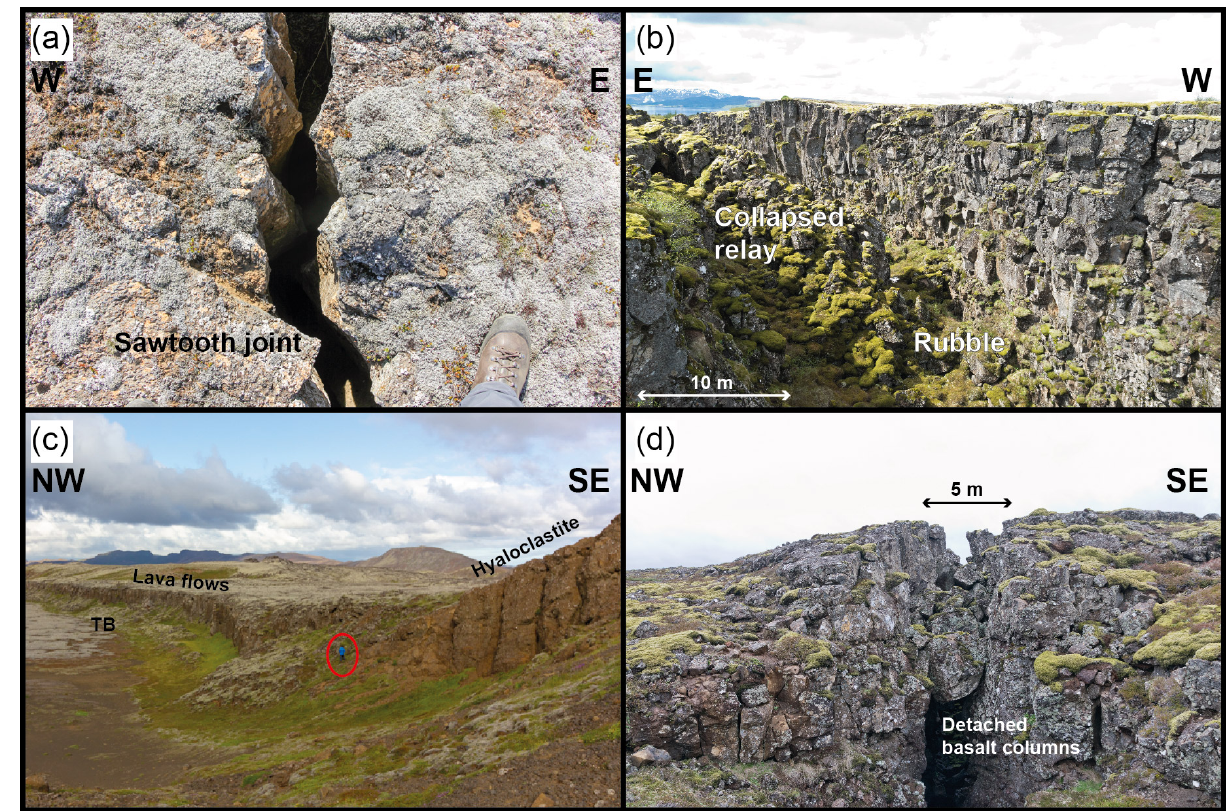
Figure 4. (a) Cooling joint with the typical sawtooth pattern; 66 ◦ 2 (cid:48) 55 (cid:48)(cid:48) N, 16 ◦ 37 (cid:48) 48 (cid:48)(cid:48) W. (b) MDF in Thingvellir. The relay has collapsed, filling the opening of the fault with rubble; 64 ◦ 14 (cid:48) 34 (cid:48)(cid:48) N, 21 ◦ 8 (cid:48) 38 (cid:48)(cid:48) W. (c) A fault that dissects different material developed tilted blocks: lava flows on the left and softer hyaloclastite on the right. Person for scale; 63 ◦ 51 (cid:48) 48 (cid:48)(cid:48) N, 22 ◦ 11 (cid:48) 41 (cid:48)(cid:48) W. (d) Side view inside a dilatant fault. Note the detached basalt columns that are stuck between the fracture walls, preventing the cavity beneath from being filled by further rubble from above; 63 ◦ 57 (cid:48) 58 (cid:48)(cid:48) N, 22 ◦ 20 (cid:48) 13 (cid:48)(cid:48)